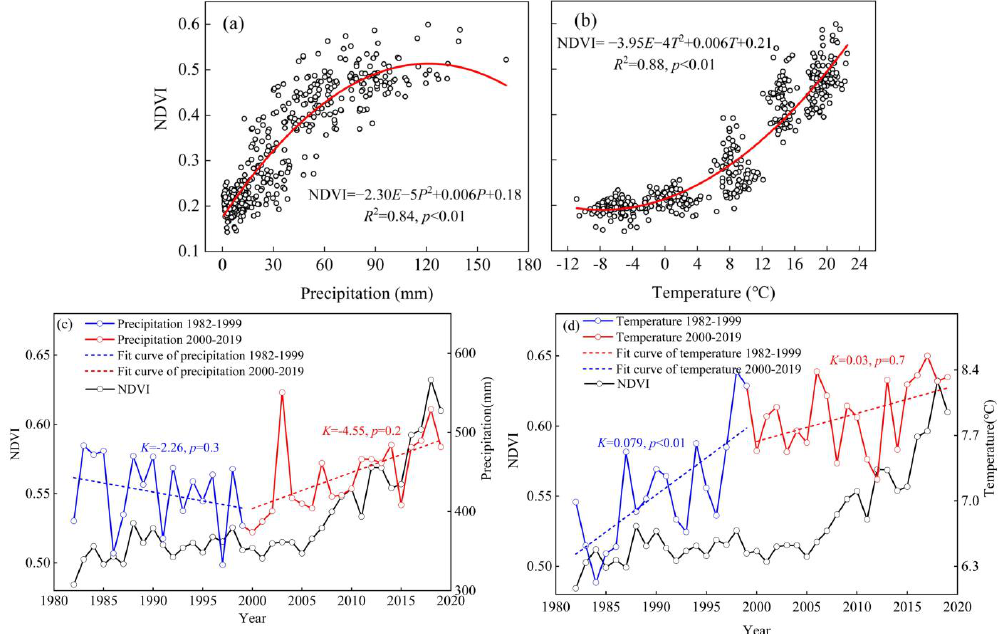
Figure 11. Qualitative analysis of the normal difference vegetation index (NDVI) and climate in the Yellow River Basin (YRB) from 1982 to 2019. ( a ) Analysis of the correlation between NDVI and precipitation, ( b ) analysis of the correlation between NDVI and temperature, ( c ) temporal variation in NDVI and precipitation, and ( d ) temporal variation in NDVI and temperature.